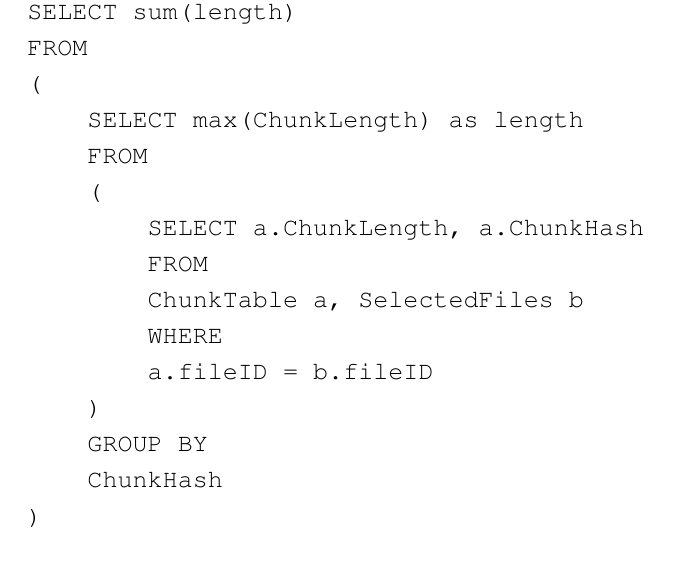
Figure 12. The SQL query of Naive for on-demand size